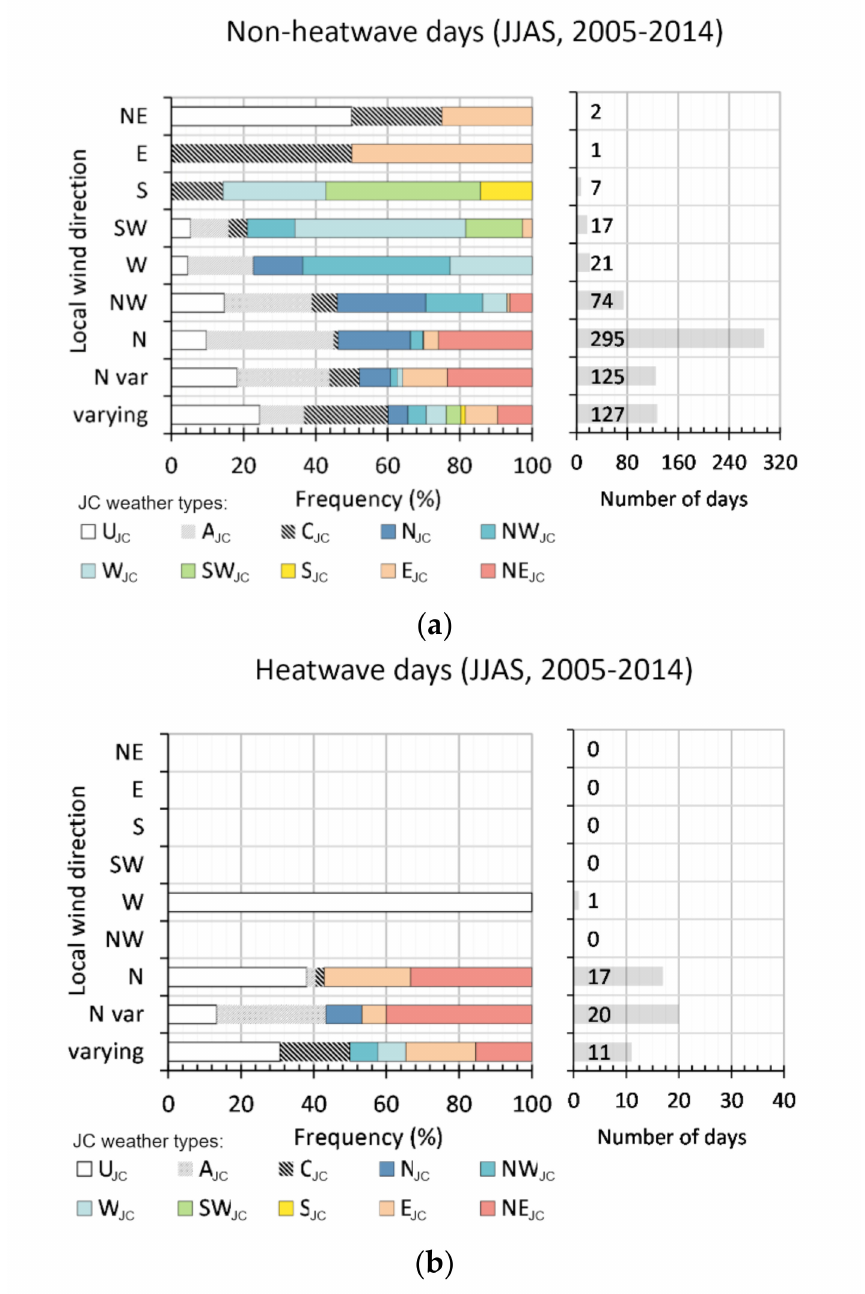
Figure 2. Frequency plots of Jenkinson–Collison (JC) weather types and the number of days, per local wind direction class and heatwave (HW)/non-heatwave (non-HW) days: ( a ) out of 669 non-HW days, local northern wind days (“N” or “N var” classes) are predominant (295 and 125 days, respectively), and show the greatest percentages of anticyclonic (A JC ) and northeast (NE JC ) synoptic flows; and ( b ) out of 49 HW days, 37 are also characterized by northern winds, and the proportion of NE JC conditions is greater. The JC weather types are described in Table